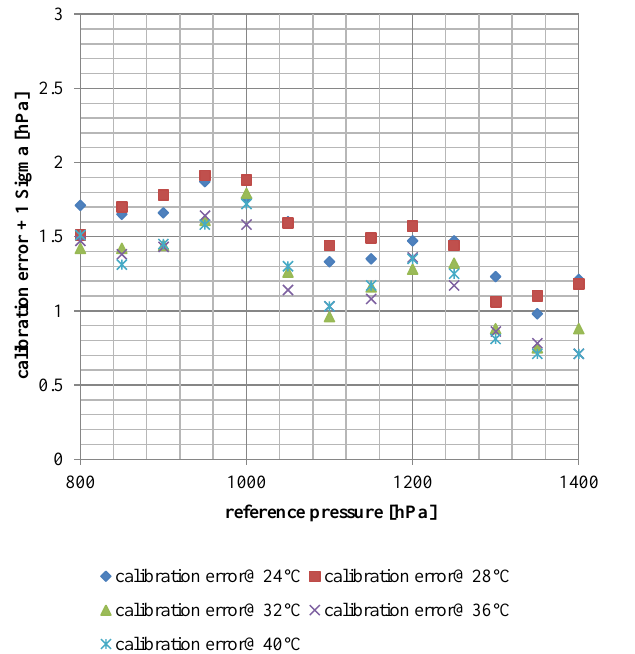
Figure 19. Pressure–calibration error (including 1-sigma noise) at different